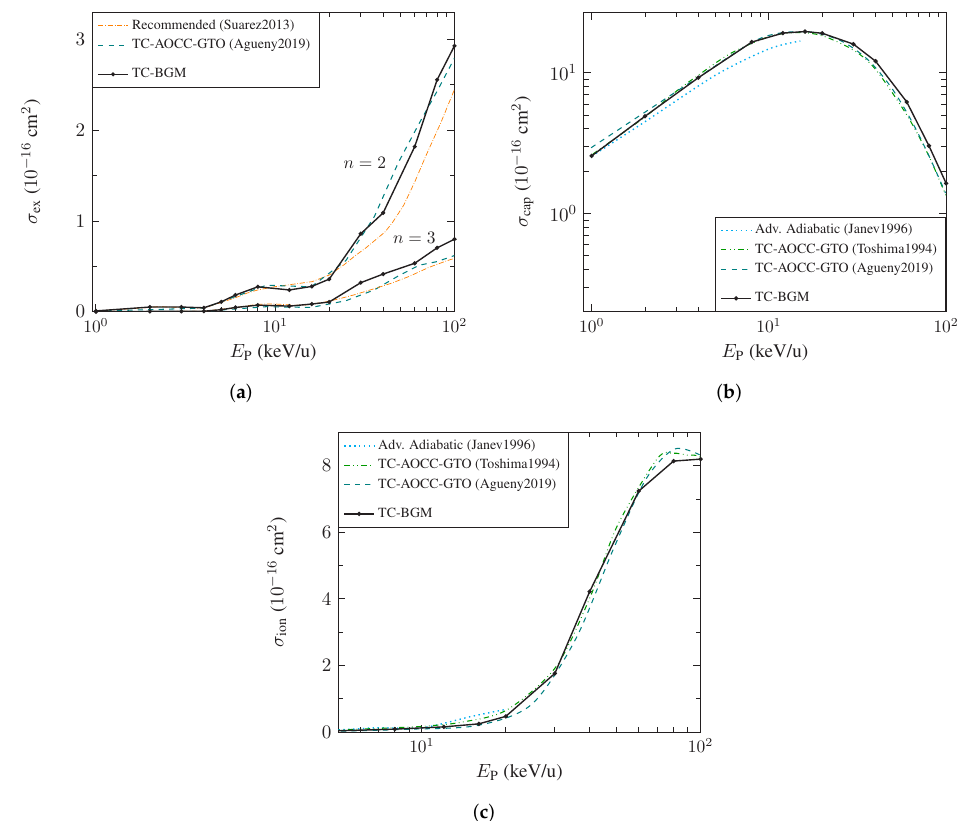
Figure 1. Cross sections of ( a ) target excitation, ( b ) electron capture, and ( c ) ionization for Li 3 + -H(1s) collisions from 1 to 100 keV/u. Recommended data from Ref. [21]. Theory: present TC-BGM, TC-AOCC-GTO [22,23], and Advanced Adiabatic